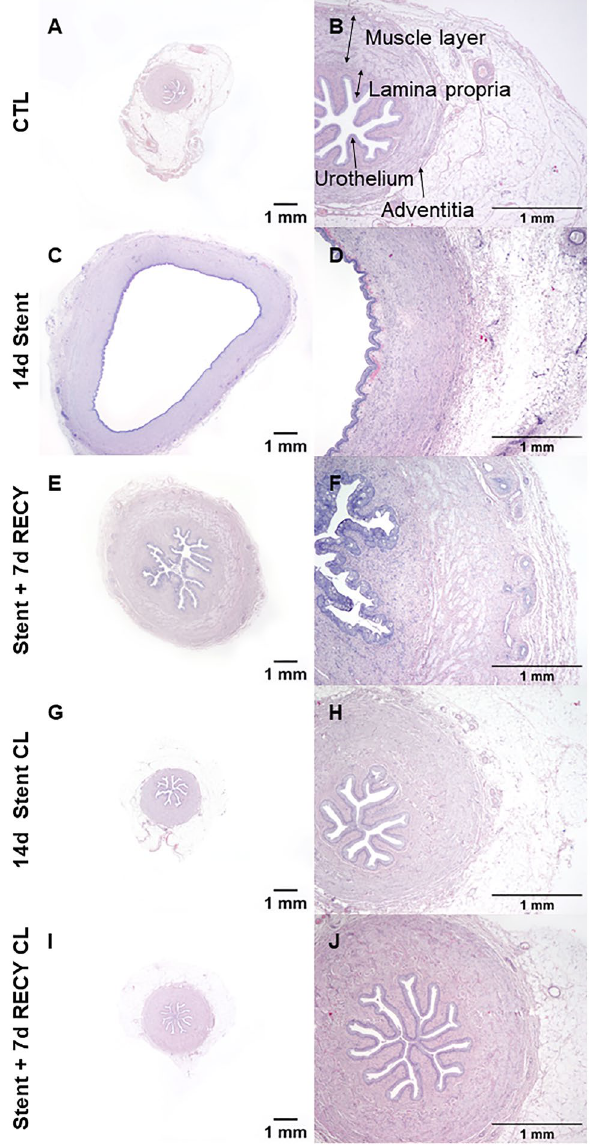
Figure 1. Ureteral morphology and alterations due to indwelling stents. ( A,B ) Regular morphology of control ureters (CTL). ( C,D ) Ureters stented for 14 days (14d Stent). ( E,F ) Ureters stented for 14 days, followed by stent removal and recovery for 7 days (Stent + 7d RECY). ( G,H ) Contralateral ureters of 14d Stent (14d Stent CL). ( I,J ) Contralateral ureters of Stent + 7d RECY(Stent + 7d RECYCL). Indwelling stents dilate the ureter and cause ureteral remodeling after 14 days of stent insertion. Morphology partially recovers 7 days after stent removal. Low and high magnification images of H&E